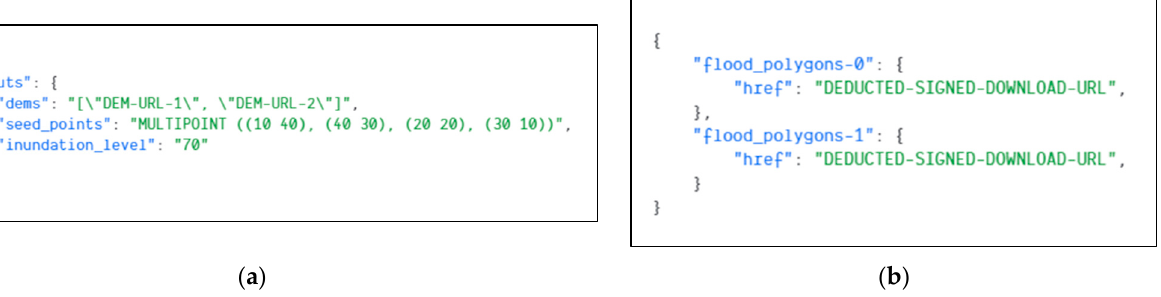
Figure 18. HTTP request payload to execute the flood prediction workflow ( a ) Workflow execution response body that has generated signed URLs to download output vector files ( b ).